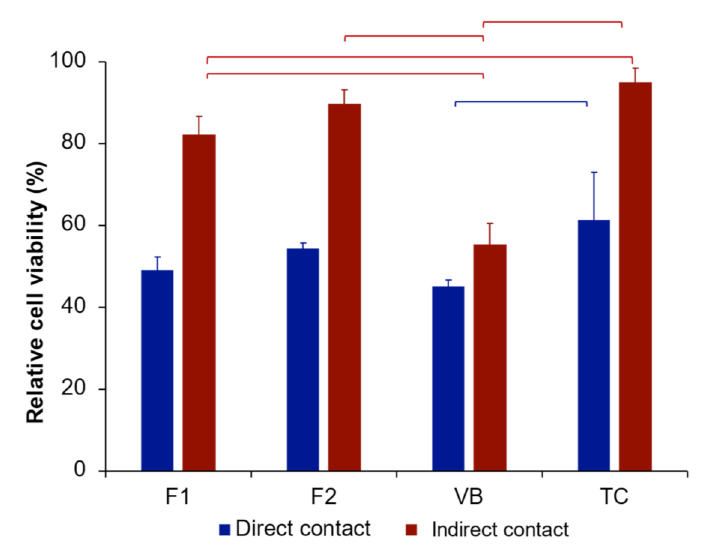
Figure 10. Relative cell viability of human dental pulp stem cells for each material from direct contact and releasing contact assessments. Error bars are SD ( n = 5). The lines indicate p <